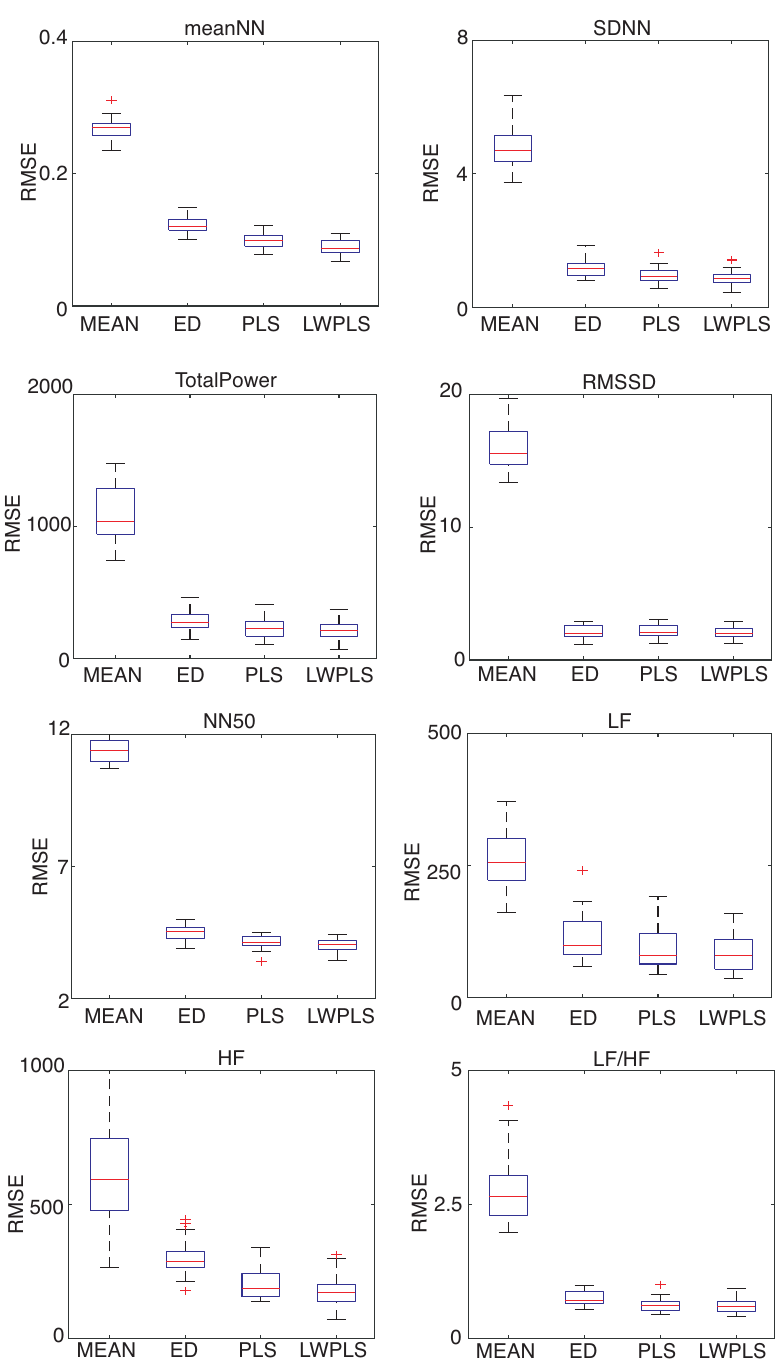
Figure 8. RMSE of HRV features derived from RRIs interpolated by MEAN, ED, PLS, and LWPLS when α = 1.0%. These eight HRV features were explained in the Appendix A. RMSEs of the four methods were calculated through a simulation repeated 30 times using all of the eighteen pieces. The proposed LWPLS-RI achieved the best HRV analysis performance. These results demonstrate the usefulness of the proposed LWPLS-RI for HRV analysis from RRI data with missing